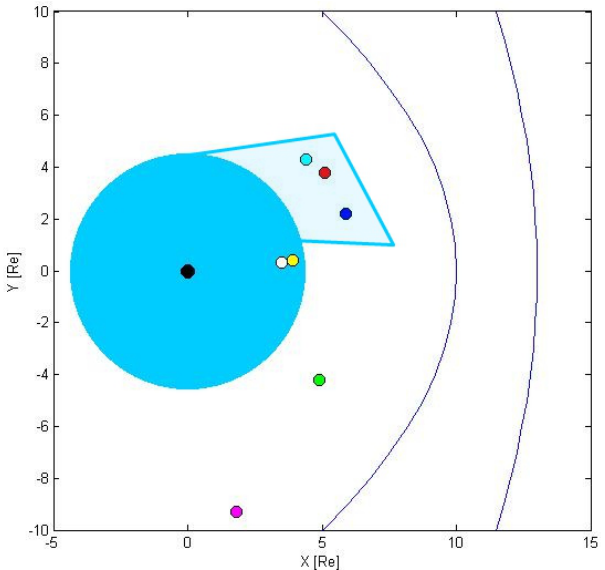
Fig. 7. GOES spacecraft observations of the total magnetic field jump for 24 events in our data set organized according to MLT. The mean level of the total magnetic field before the IP shock response (B t in nT) has been subtracted. First panel shows the observations when the spacecraft were located between 6 to 12 MLT, the middle panel between 12 and 15 MLT, and the last panel between 15 to 18 MLT. The scale of the x-axis is 1 point = 0.512 s. Fig. 9. Sketch of the plasmaspheric bulge from the first event on November 19, 2007. The yellow and white dots denote the Cluster- 4 and 2 spacecraft located in the edge of the plasmasphere illus- trated by the light blue circle. Red and blue dots represent GOES 10 and 12 locations within the plasmaspheric bulge illustrated with the blue shaded area. The green dot represents GOES 11 spacecraft located in the dayside geostationary orbit outside the plasmaspheric bulge. The cyan dot shows LANL-94 location and the magenta dot shows THEMIS-D location. The bow shock and magnetopause are illustrated by the blue solid lines.